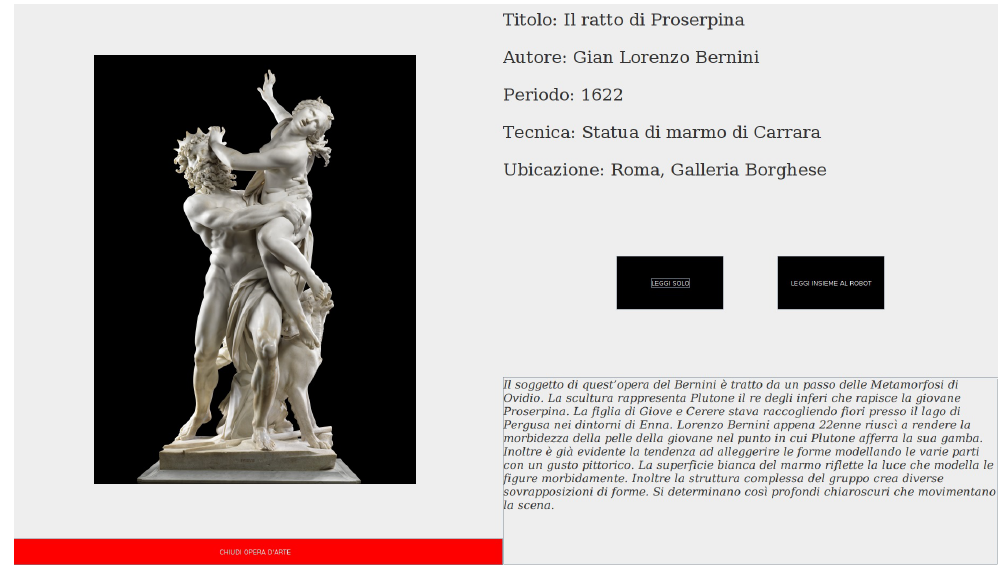
Figure 3. Example of artwork. On the left, there is a copy of the artwork, on the right, is placed the artwork’s description. If the level of accuracy is high, the user can read, in addition to the basic characteristics (Title, Author, Date, Tecnique, Location), a more detailed description. The description can be read by the robot as well as by the user. If the level is low, the bottom right description is excluded. (Image credits: Galleria Borghese/photo Luciano Romano).